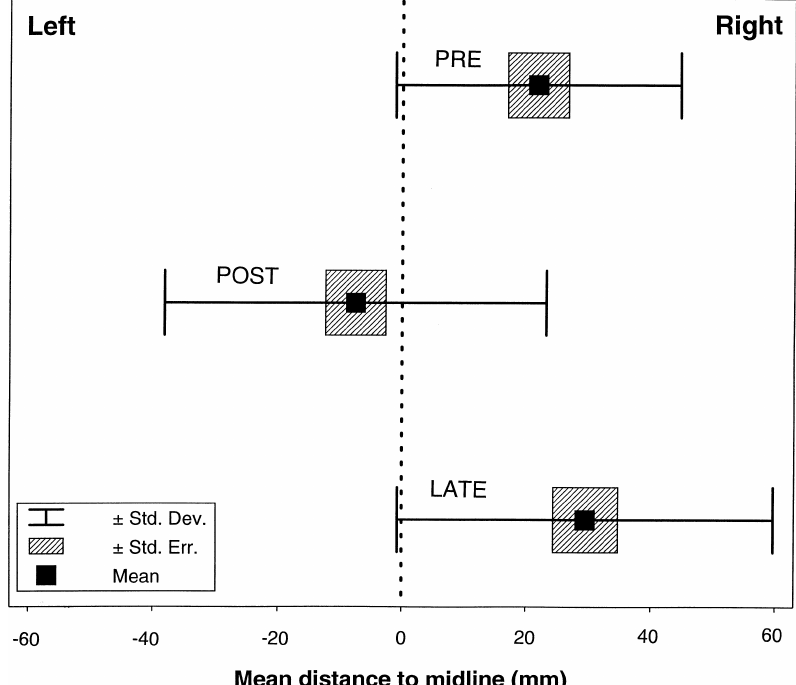
Fig. 5. Mean horizontal distance of named towns measured from the map midline (Perpignan-Lille axis) prior to prism exposure (Pre-test), immediately after prism adaptation (Post-test) and after a delay about 24 hours following the prism exposure (Late-test). Box indicates standard errors of the mean and the whiskers indicates standard deviations. Both the mean deviation to midline and its variance were affected by the adaptation in the Post-test. The effect of adaptation lasted over 24h only for the horizontal